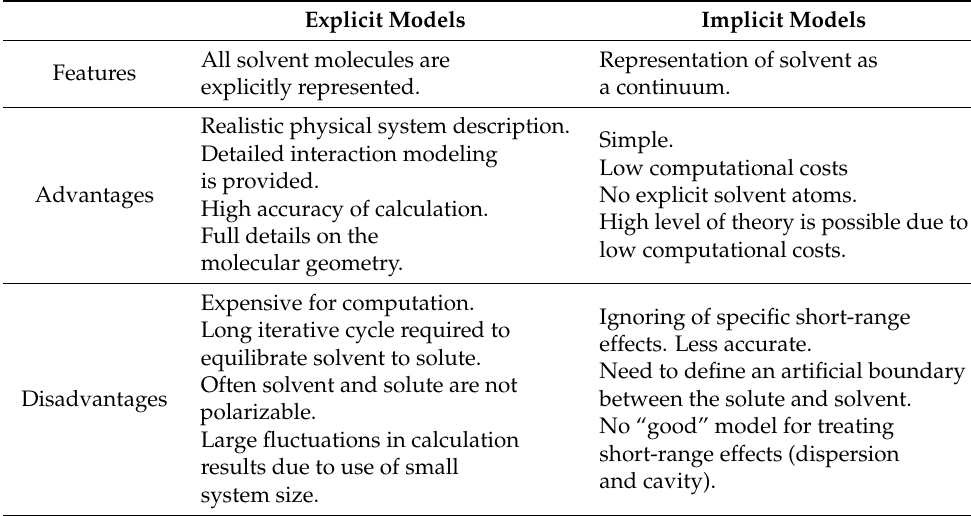
Table 1. Comparison of explicit and implicit solvent models for